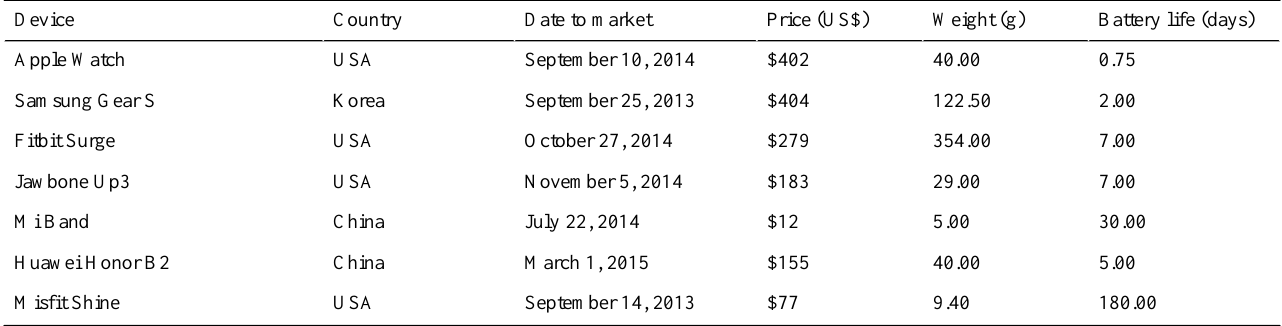
Table 2. Major attributes of the seven wearable